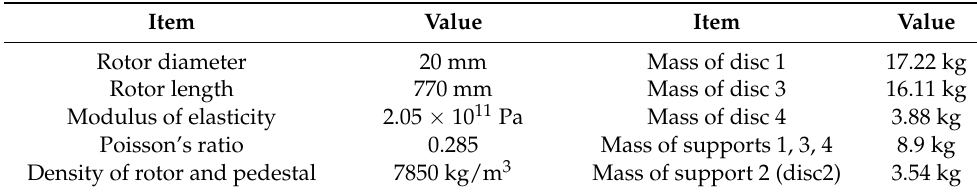
Table 1. The main dimensions and material properties of the rotor system.